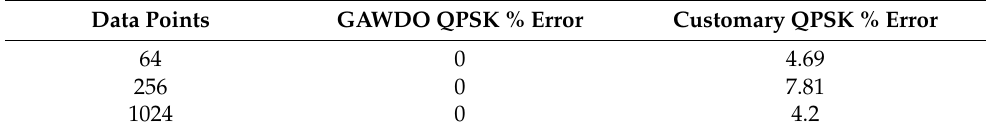
Table 4. BER comparison between GAWDO and customary QPSK in a noiseless OFDM network. Data Points